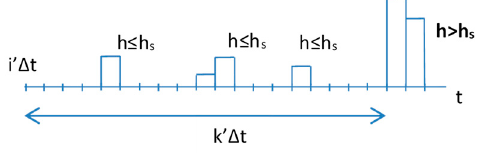
Figure 1. Sketch of the dry spells sequence k’ Δ t of rainfall events h , each lower than the threshold h s .